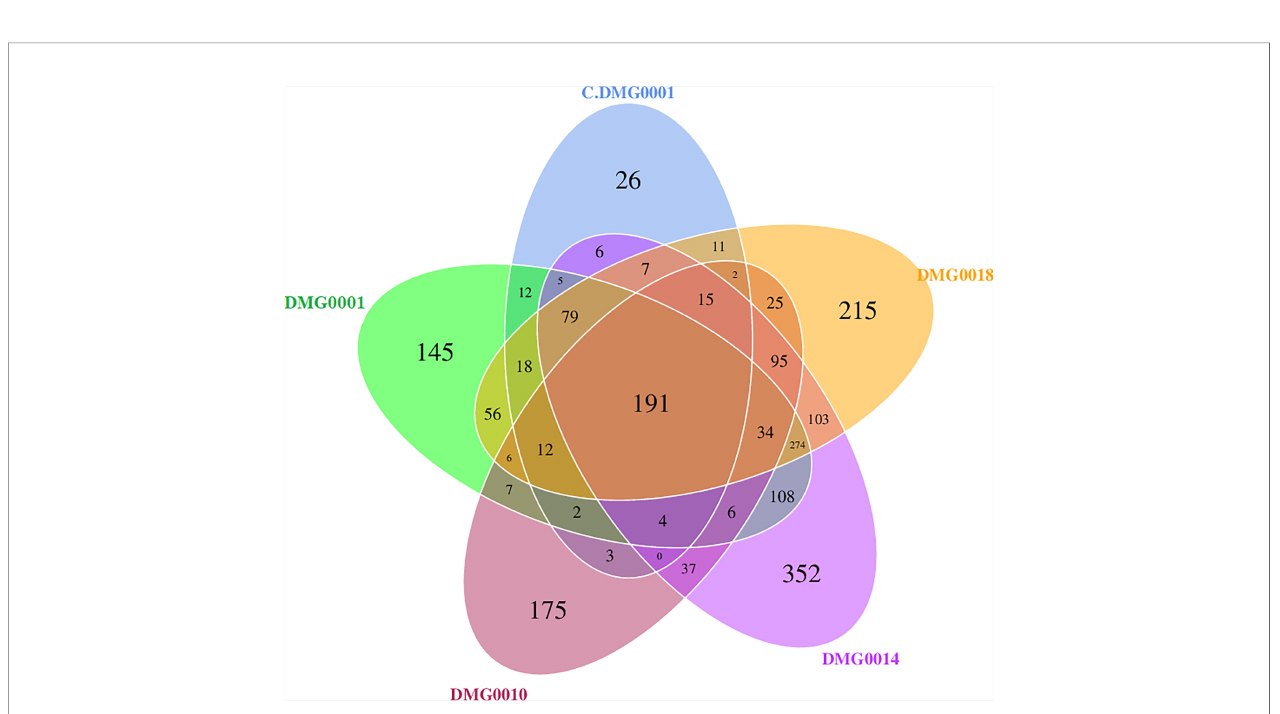
FIGURE 6 | Venn diagram showing malacopathogenic nematodes associate with a core set of bacteria from the phyla Pseudomonadota, Bacillota, Actinobacteriota and Bacteroidota. P. neopapillosa (DMG0014) has the high number of unique bacteria (352) which was not found in the other species. P. hermaphrodita (C.DMG0001) with did not kill a slug had the lowest unique number of bacteria 26 and the lowest diversity overall.